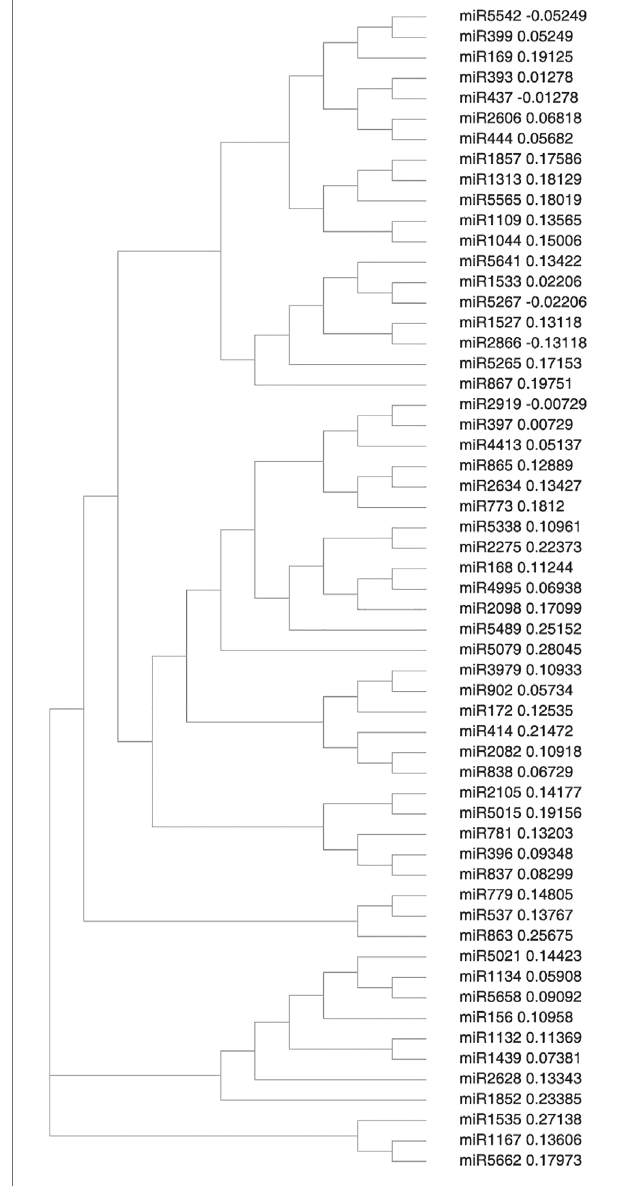
FIGURE 3 | Phylogenetic relationship among predicted miRNA families in cluster